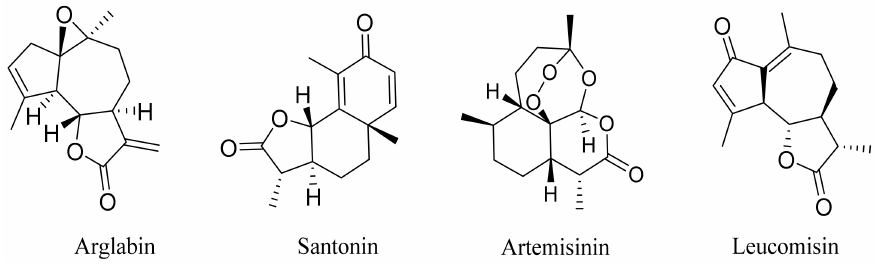
Figure 2. Prominent examples of sesquiterpene lactones isolated from Artemisa